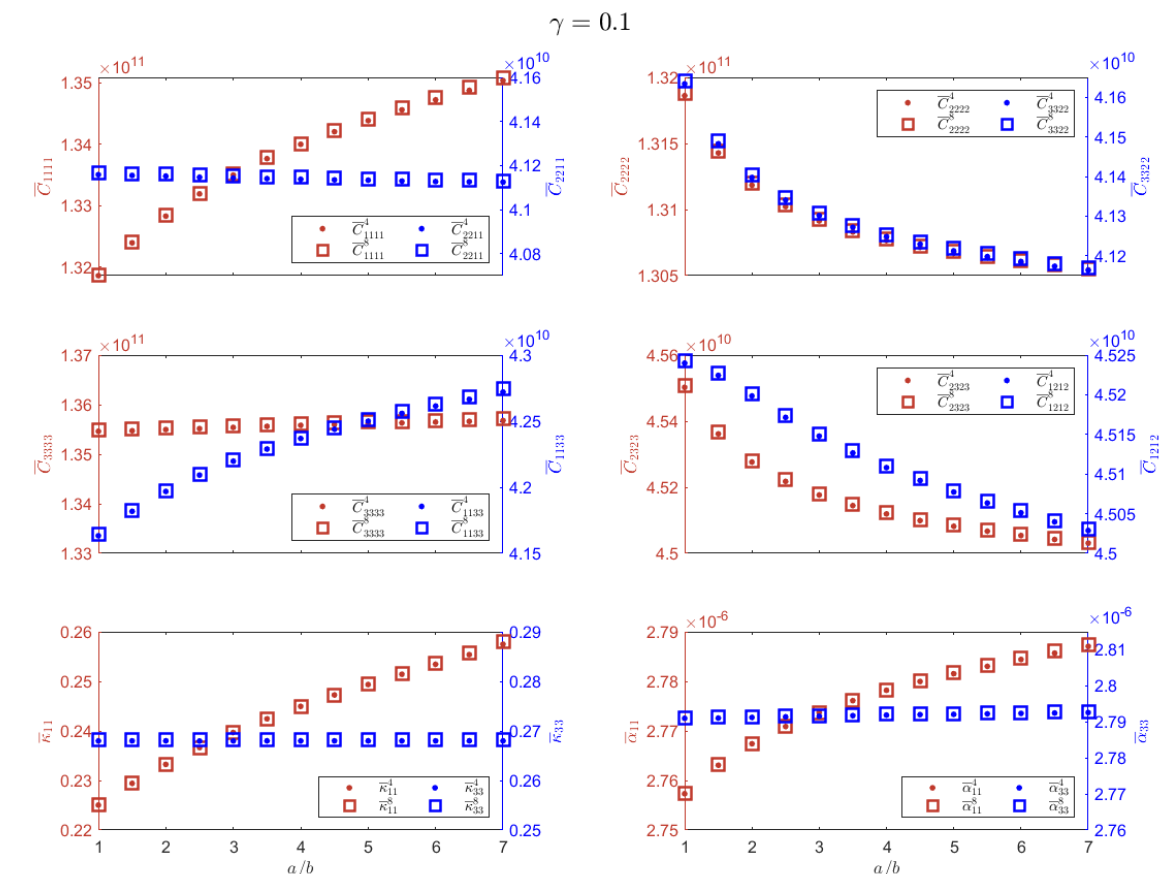
Figure 10. Effective properties for different aspect ratios of the ellipse and γ =